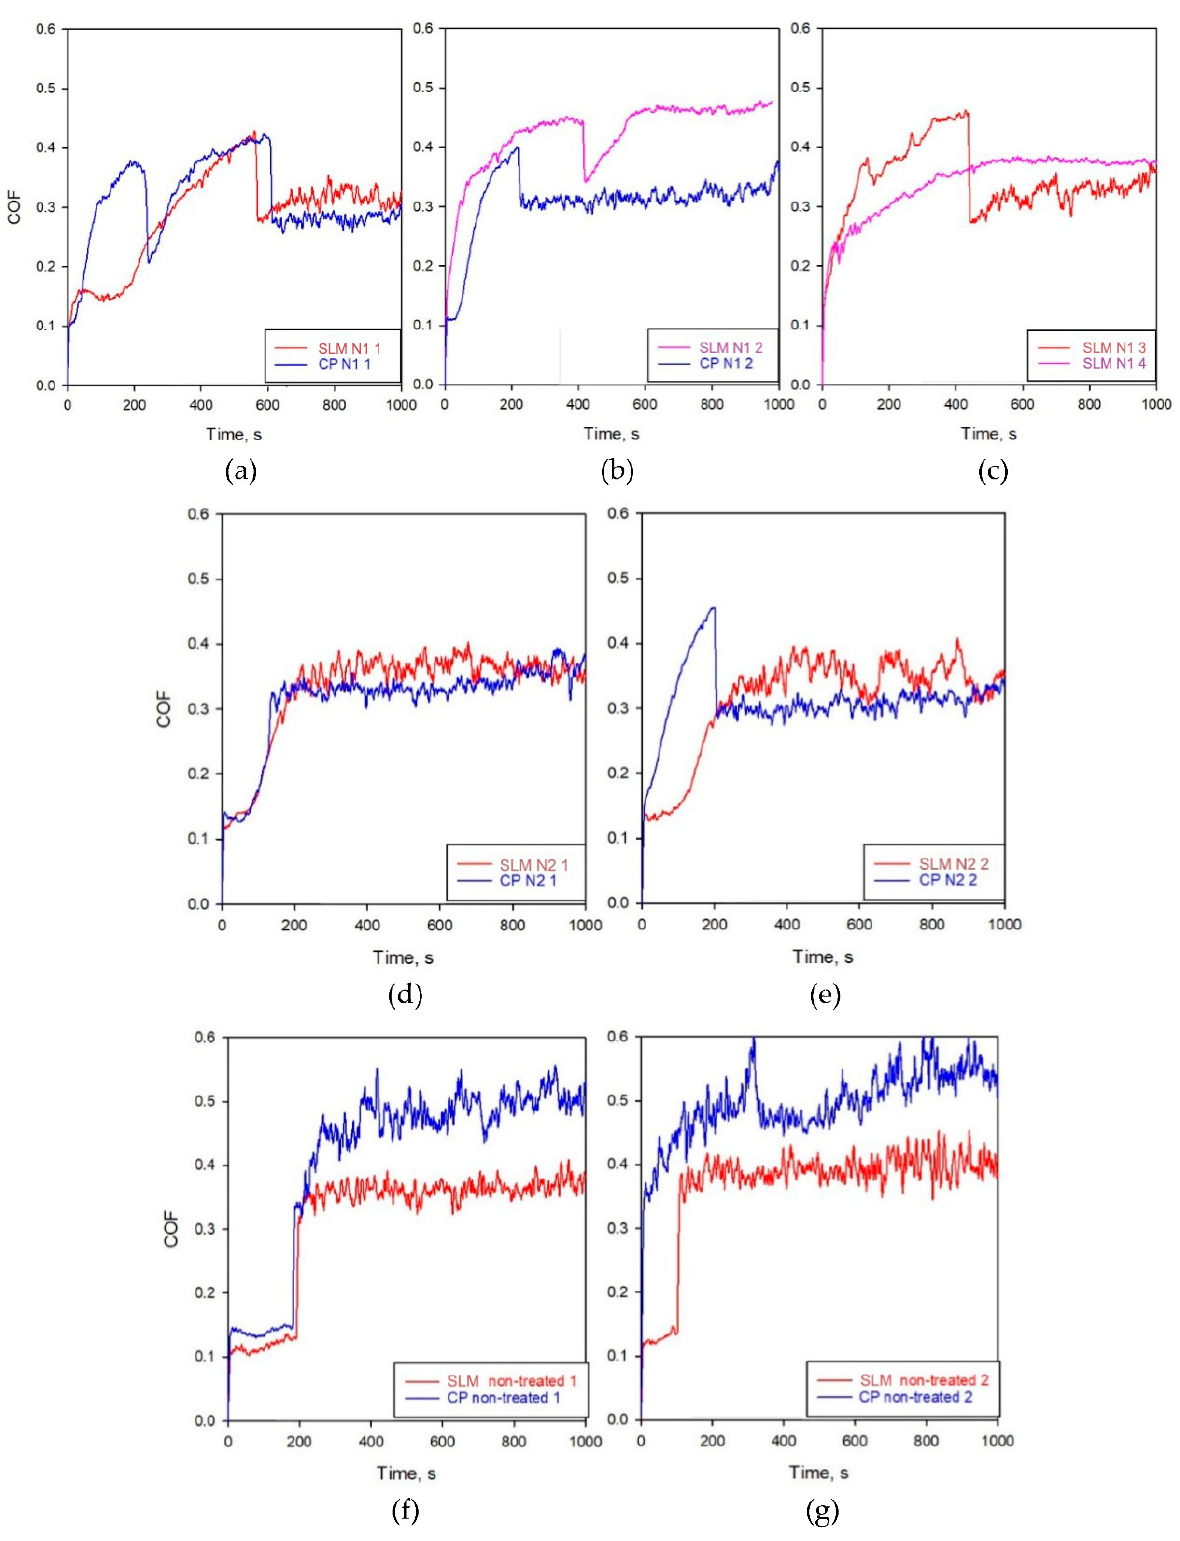
Figure 7. COF plots for ( a ) SLM and CP N1 first tests, ( b ) SLM and CP N1 second tests, ( c ) SLM N1 the third and fourth tests, ( d ) SLM and CP N2 first tests, ( e ) SLM and CP N2 second tests, ( f ) SLM and CP non-treated sample first tests, and ( g ) SLM and CP non-treated sample second tests.